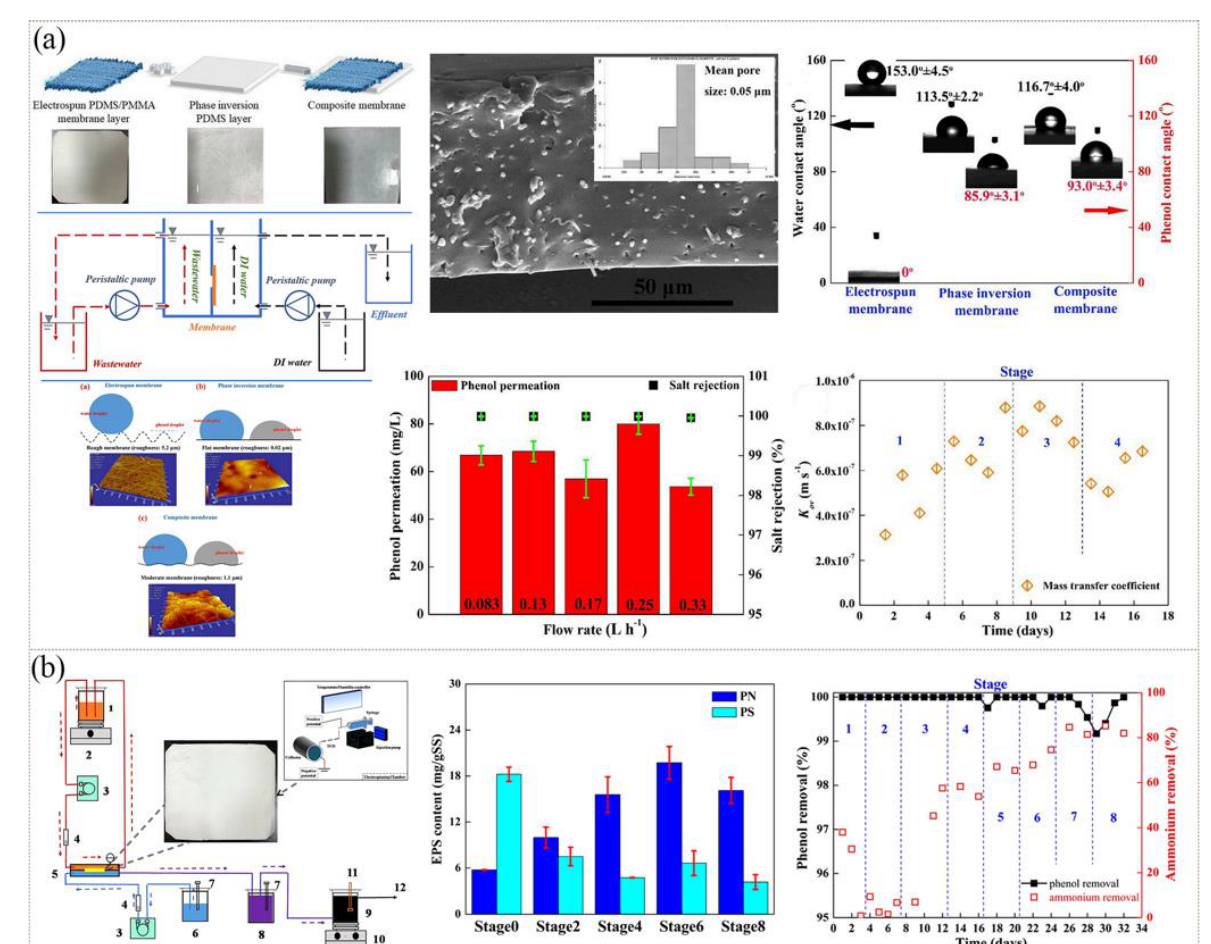
Figure 9. Preparation process, microstructure, and properties of MBR membranes: ( a ) PDMS mem- brane. Reprinted with permission from Refs. [130,132]. Copyright 2020 Elsevier Ltd., Copyright 2019